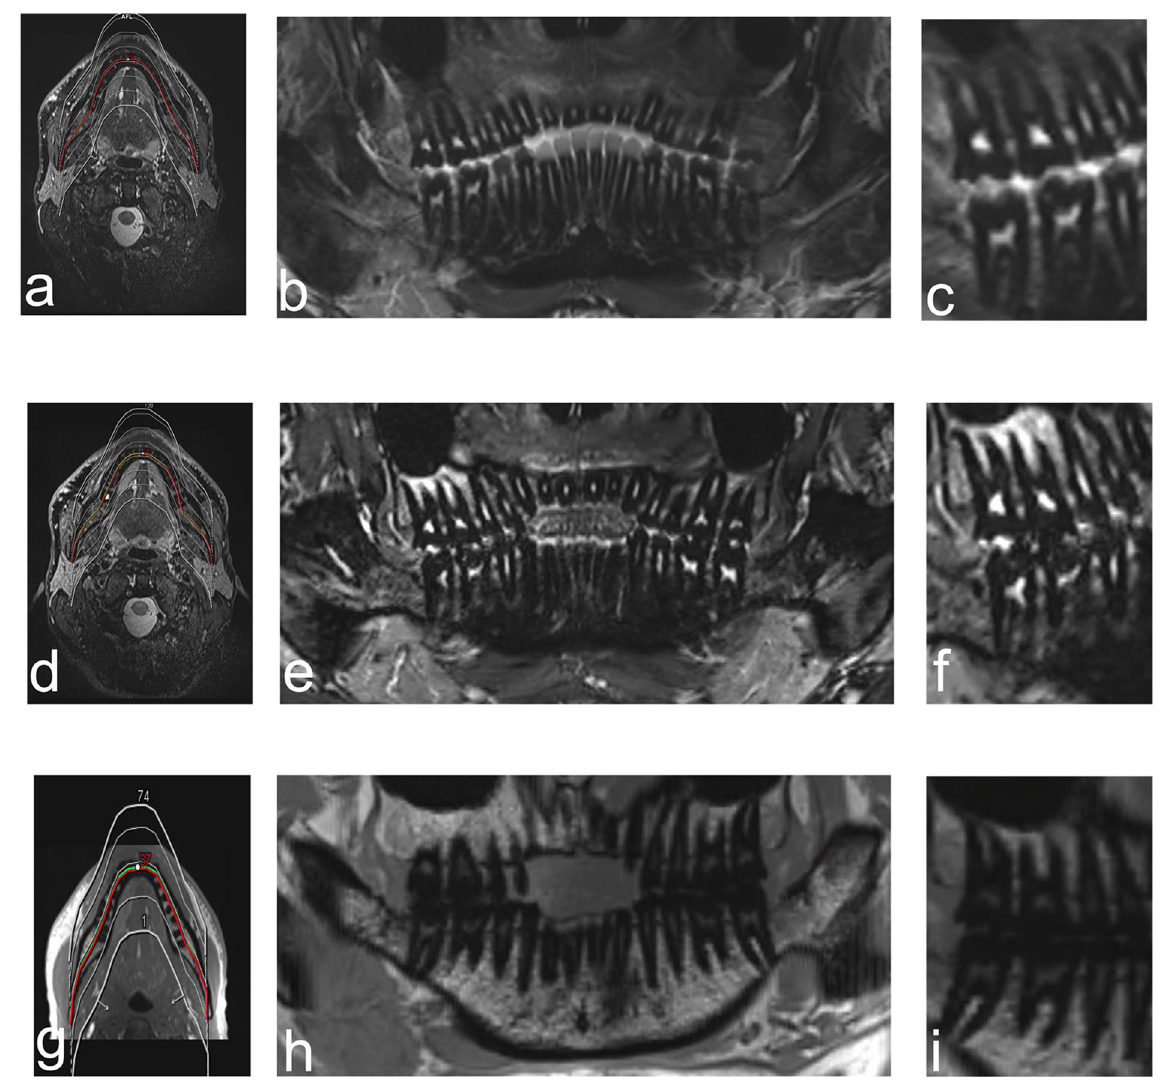
Figure 3. OPG (orthopantomogram) MRI reconstructions (MR-OPG) from ( a – c ) 3D fast spin echo short-tau inversion recovery (SPACE STIR), ( d – f ) 3D fast spin echo spectral attenuated inversion recovery (SPACE- SPAIR), and ( g – i ) volumetric interpolated breath-hold examination (T1-VIBE-Dixon) datasets. ( a ), ( d ) and ( g ) show the planning of the MR-OPG images. Orthopantomogram-like MR images using ( b ) (SPACE-STIR), ( e ) (SPACE-SPAIR), and ( h ) (VIBE-Dixon) sequences. ( c ), ( f ) and ( i ) visualize the anatomy of teeth in ( c ) (SPACE- STIR), ( f ) (SPACE-SPAIR), and ( i ) (VIBE-Dixon)